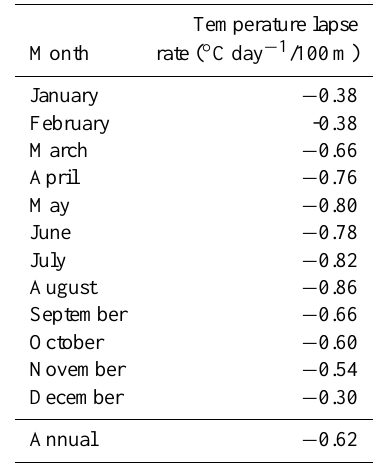
Table 1. Estimated monthly temperature lapse rate in the